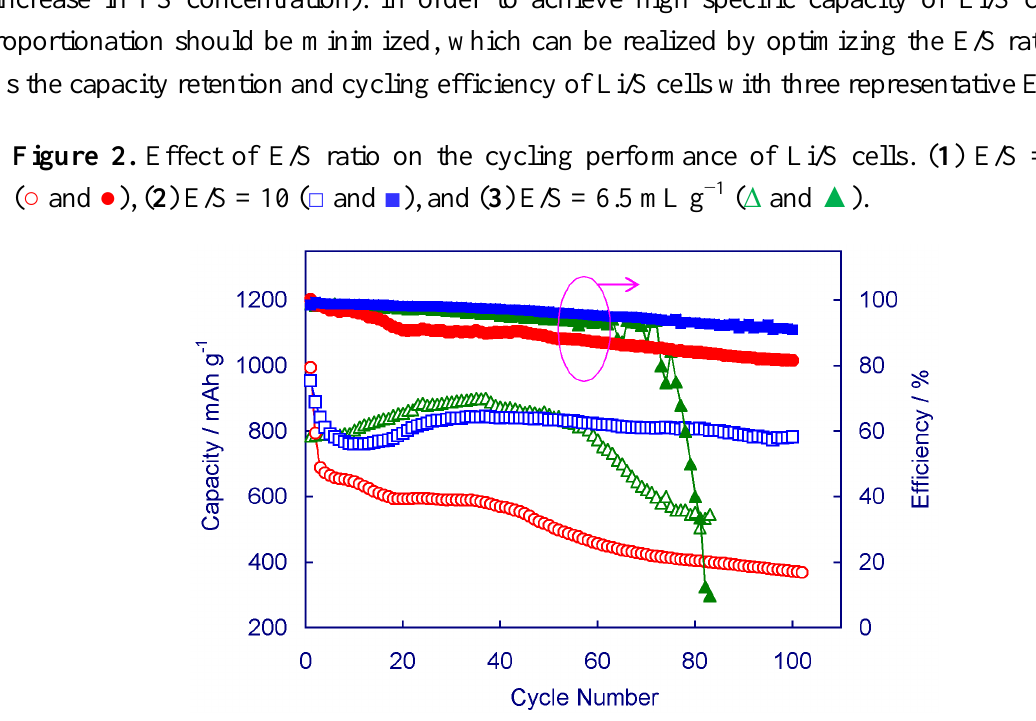
Cell 1 having an E/S = 13.3 mL g −1 (shown in circle symbols) is an example of cells with an